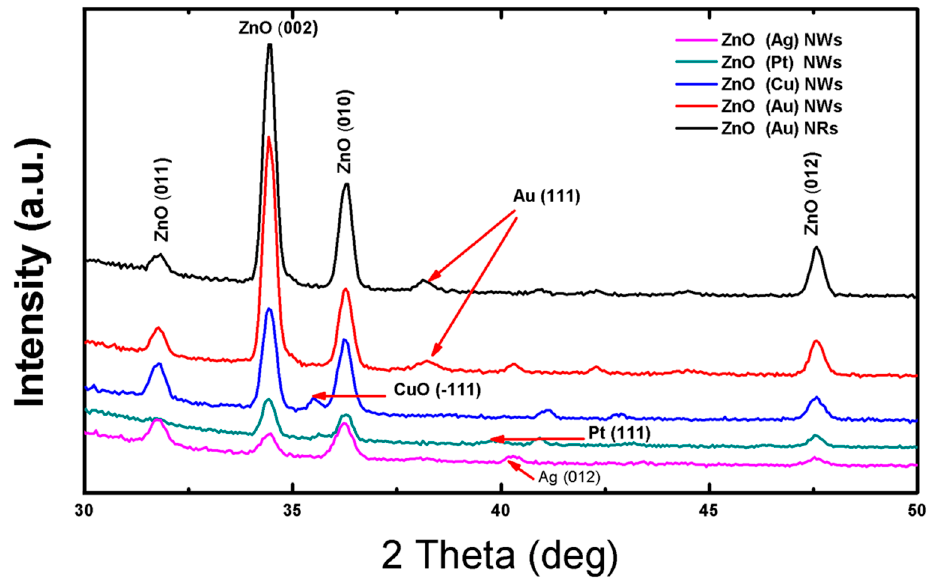
Figure 4. X -ray di ff raction patterns of 1-D ZnO synthetized using various catalysts. Figure 4. X -ray diffraction patterns of 1-D ZnO synthetized using various catalysts . Table2. Thecrystallitesizeandtheaveragelengthofthe1DZnOnanostructuresusingdi ff erentcatalysts. Table 2. The crystallite size and the average length of the 1D ZnO nanostructures using different catalysts. Sample Crystallite Size